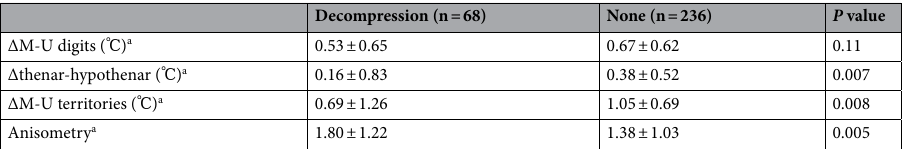
Table 4. Values of each index according to the surgical decision. a All continuous values were expressed as mean ± standard deviation.